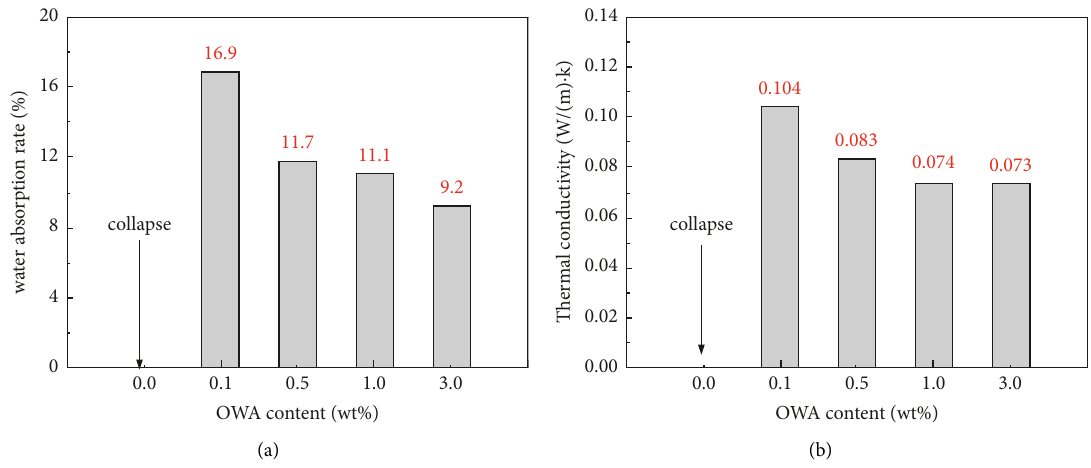
Figure 2: Effect of different OWA content on (a) water absorption rate and (b) thermal